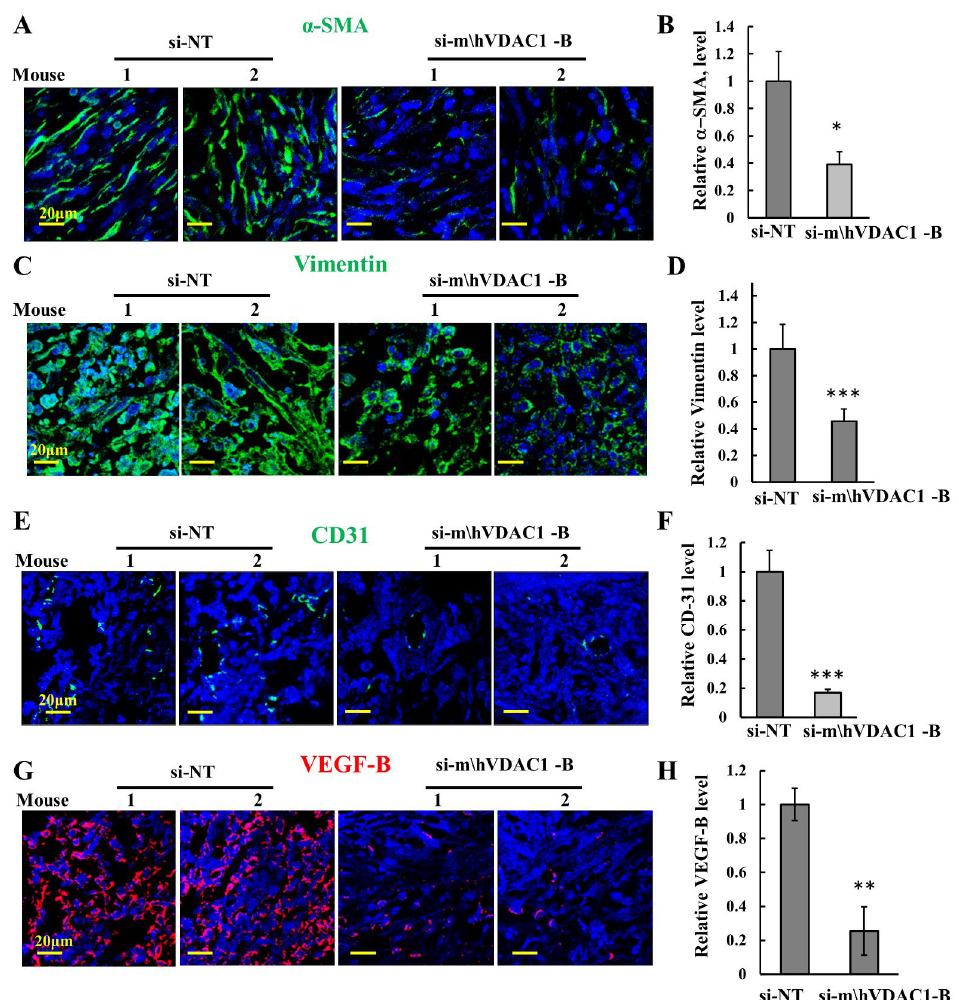
Figure 6. Silencing VDAC1 expression modulates the tumor microenvironment. Representative im- munofluorescence images of sections from si-m/hVDAC1-B-treated or si-NT-treated H226-cell-de- rived tumors stained and quantified for α -SMA ( A , B ), and vimentin ( C , D ), CD-31 ( E , F ), and VEGF ( G , H ). Results represent the means ± SEM (n = 3) * p ≤ 0.05, ** p ≤ 0.01, *** p ≤ 0.001. We also assessed angiogenesis by analyzing the expression of CD-31, a specific en- dothelial marker, and of vascular endothelial growth factor (VEGF) (Figure 6 E – H). In agreement with a previous report showing that in mesotheliomas CD-31 staining is rare [53], the expression of CD-31 in mesothelioma was very low, yet it was highly reduced in si-m/hVDAC1-B-treated tumors (Figure 6 E,F). VEGF staining was reduced in the si- m/hVDAC1-B-treated tumors (Figure 5G,H). As inflammation plays a critical role in the